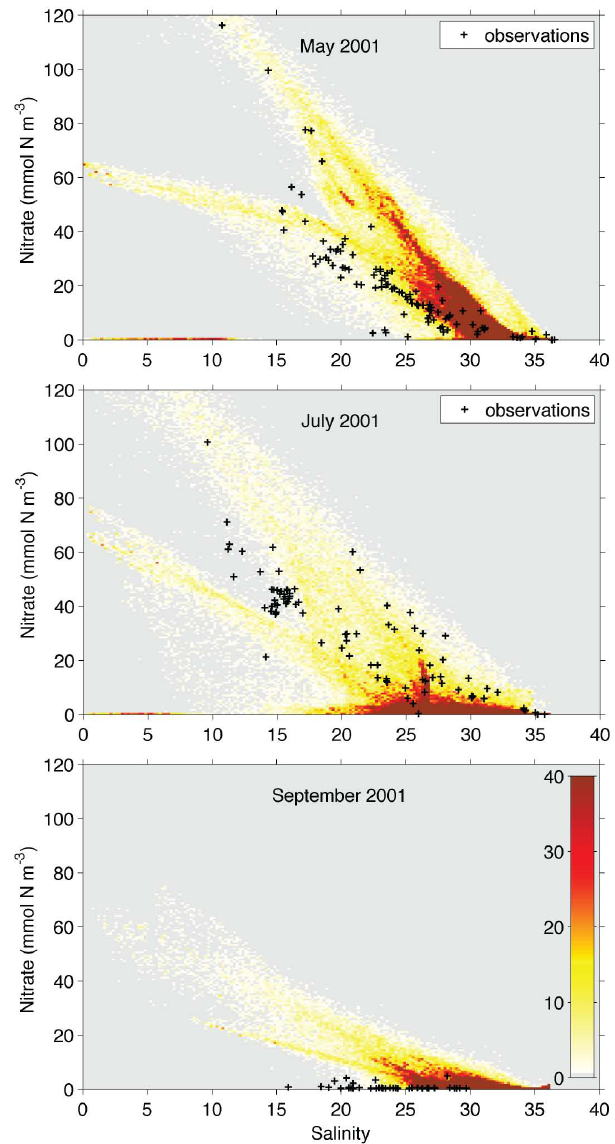
Fig. 4. Simulated surface nitrate concentrations are shown over salinity in form of a 2-dimensional histogram. All surface cells in the model domain are included. Color indicates the number of sim- ulated nitrate-salinity-pairs per bin (see color scale in bottom right panel). Symbols represent surface nitrate observations for the same